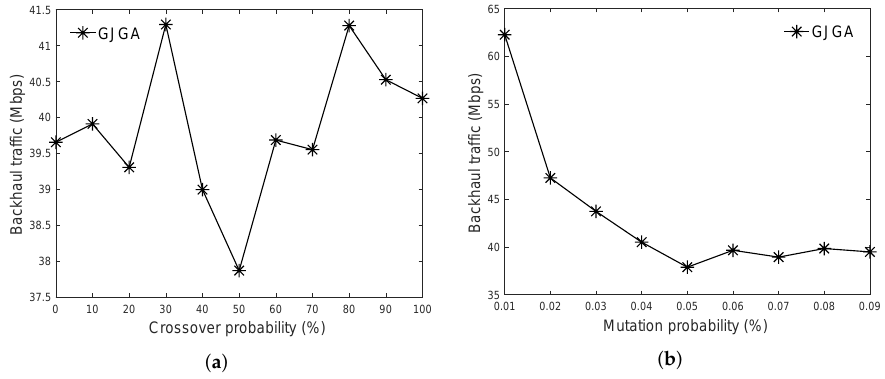
Figure 3. Effects of different crossover and mutation probabilities on the total backhaul traffic under 600 UEs, cache size of 4000, 8000 files, and 1000 generations. ( a ) Crossover under the mutation probability of 0.05%. ( b ) Mutation under the crossover probability of 50%.